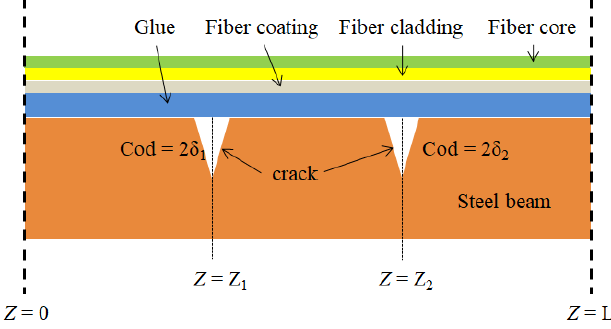
Figure 1. Distribution optical fiber sensor with two cracks.